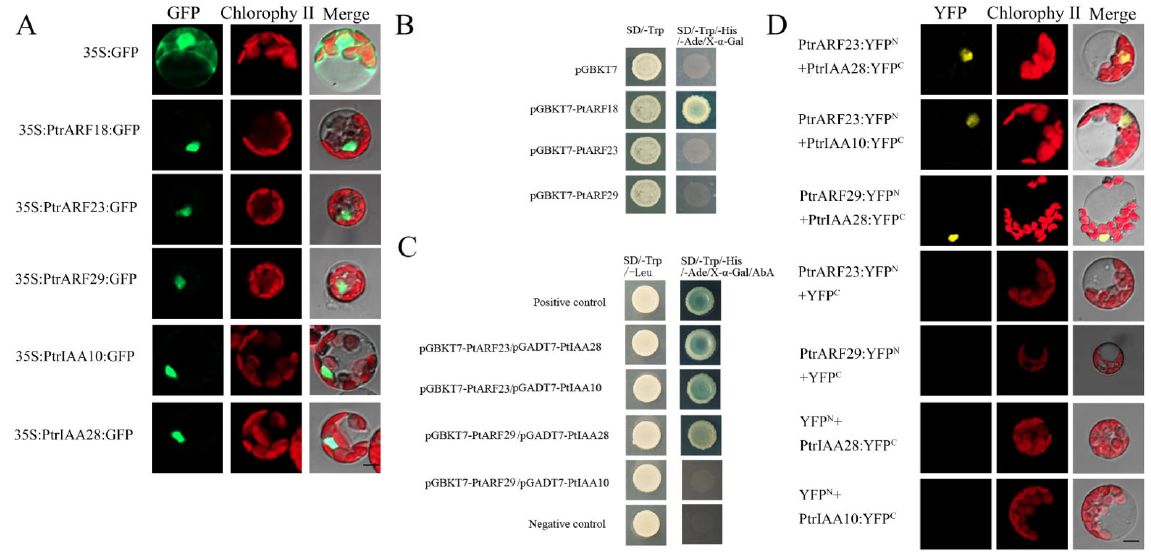
Figure 9. Subcellular localization, transcriptional self-activation, and protein–protein interactions. ( A ) Subcellular localization of PtrARF18, PtrARF23, PtrARF29, PtrIAA10, and PtrIAA28